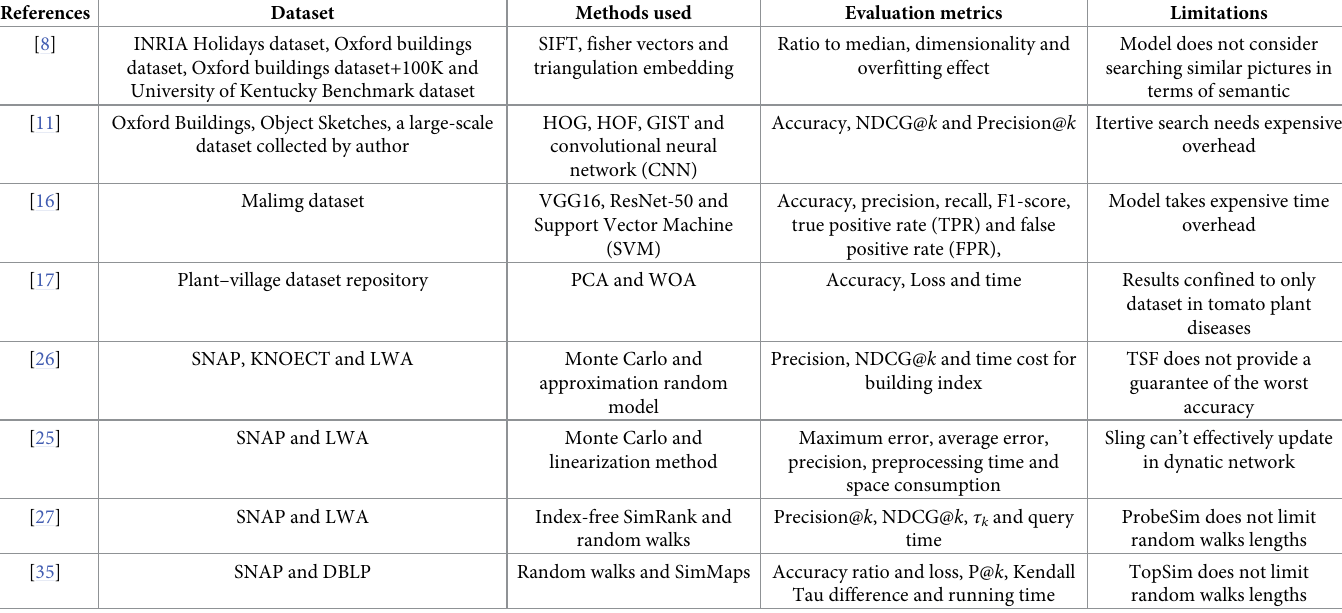
Table 1. Summary of related studies on searching similar